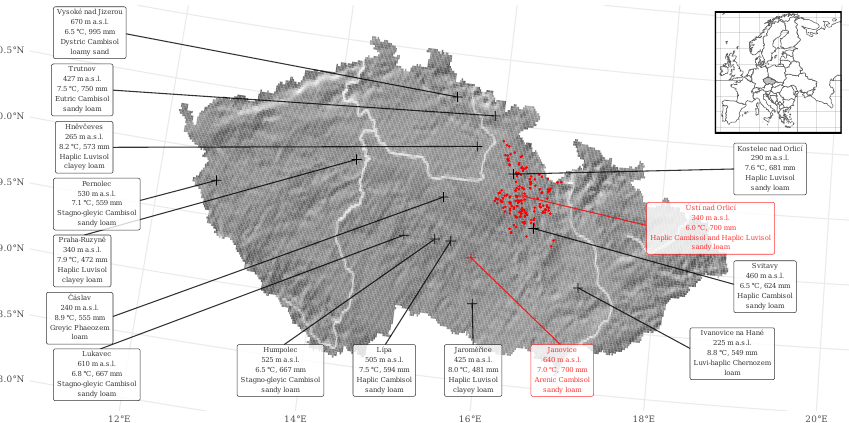
Figure 1. Locations, altitudes, mean annual temperatures, and precipitation sums in the years of data collection, and soil types and textures at the experimental sites. The target sites are marked with red color. For Ústí nad Orlicí, individual soil sampling locations are displayed, and their mean altitude is